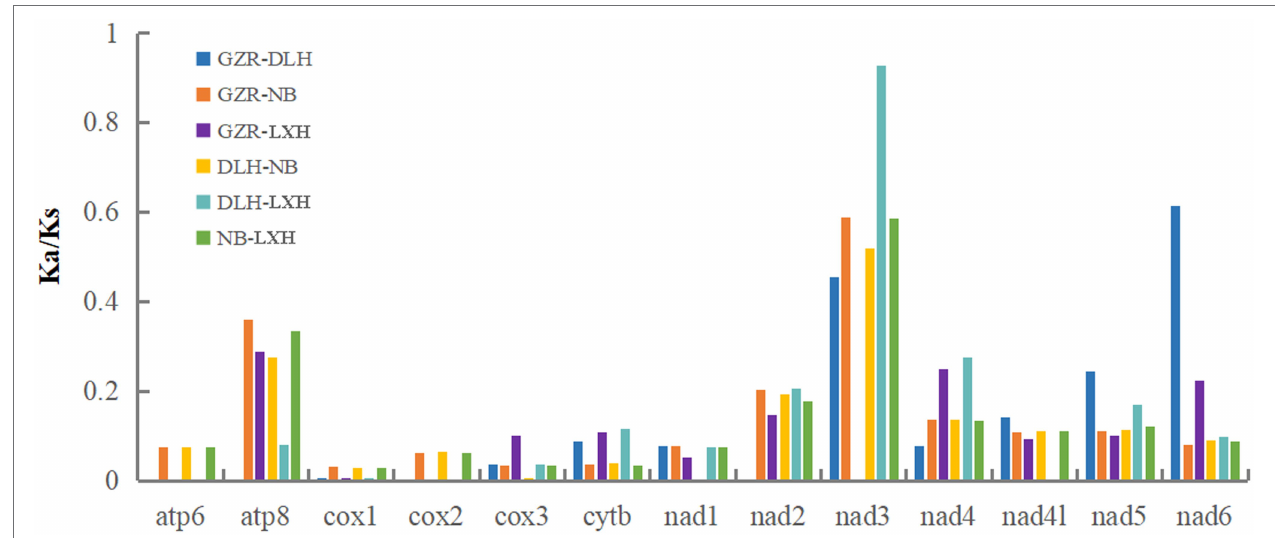
FIGURE 4 | The evolutionary rate indicated by Ka/Ks for each PCG in the four representative mitogenomes of P. tunguidus (see Table 1 ). The names of 13 PCGs are shown on the X -axis, and the ratio of Ka/Ks is shown on the Y -axis.